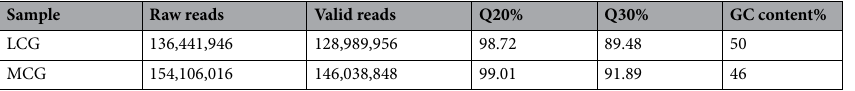
Table 1. Sequence statistics and quality control of lncRNAs, circRNAs and